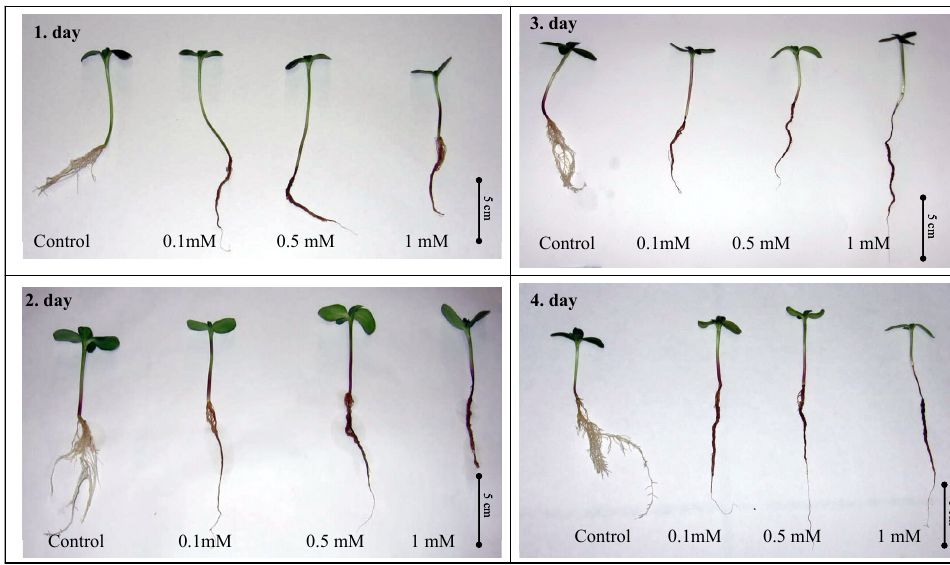
Figure 3. Images of the sunflower plants during 96 h treatment with silver(I) ions.